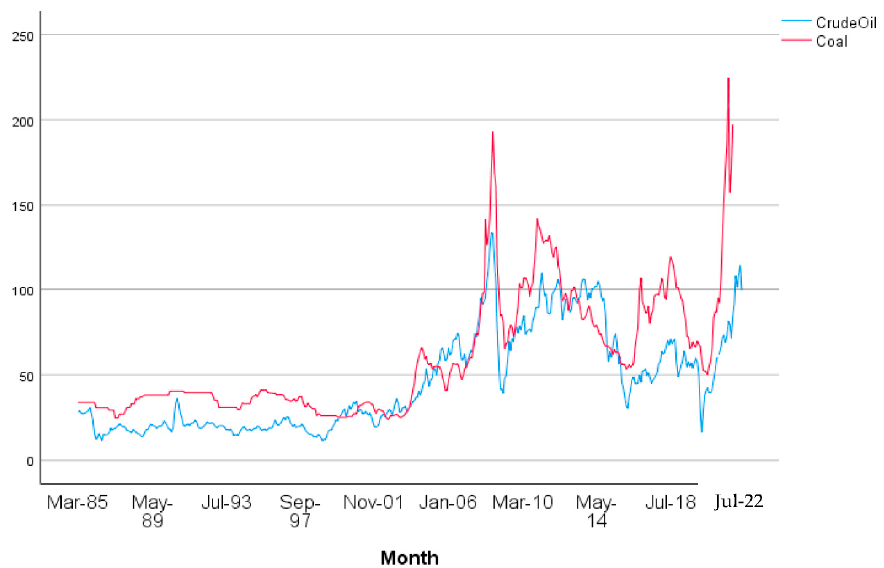
Figure 2. Time-Series Plot of Crude Oil and Coal Price Patterns.